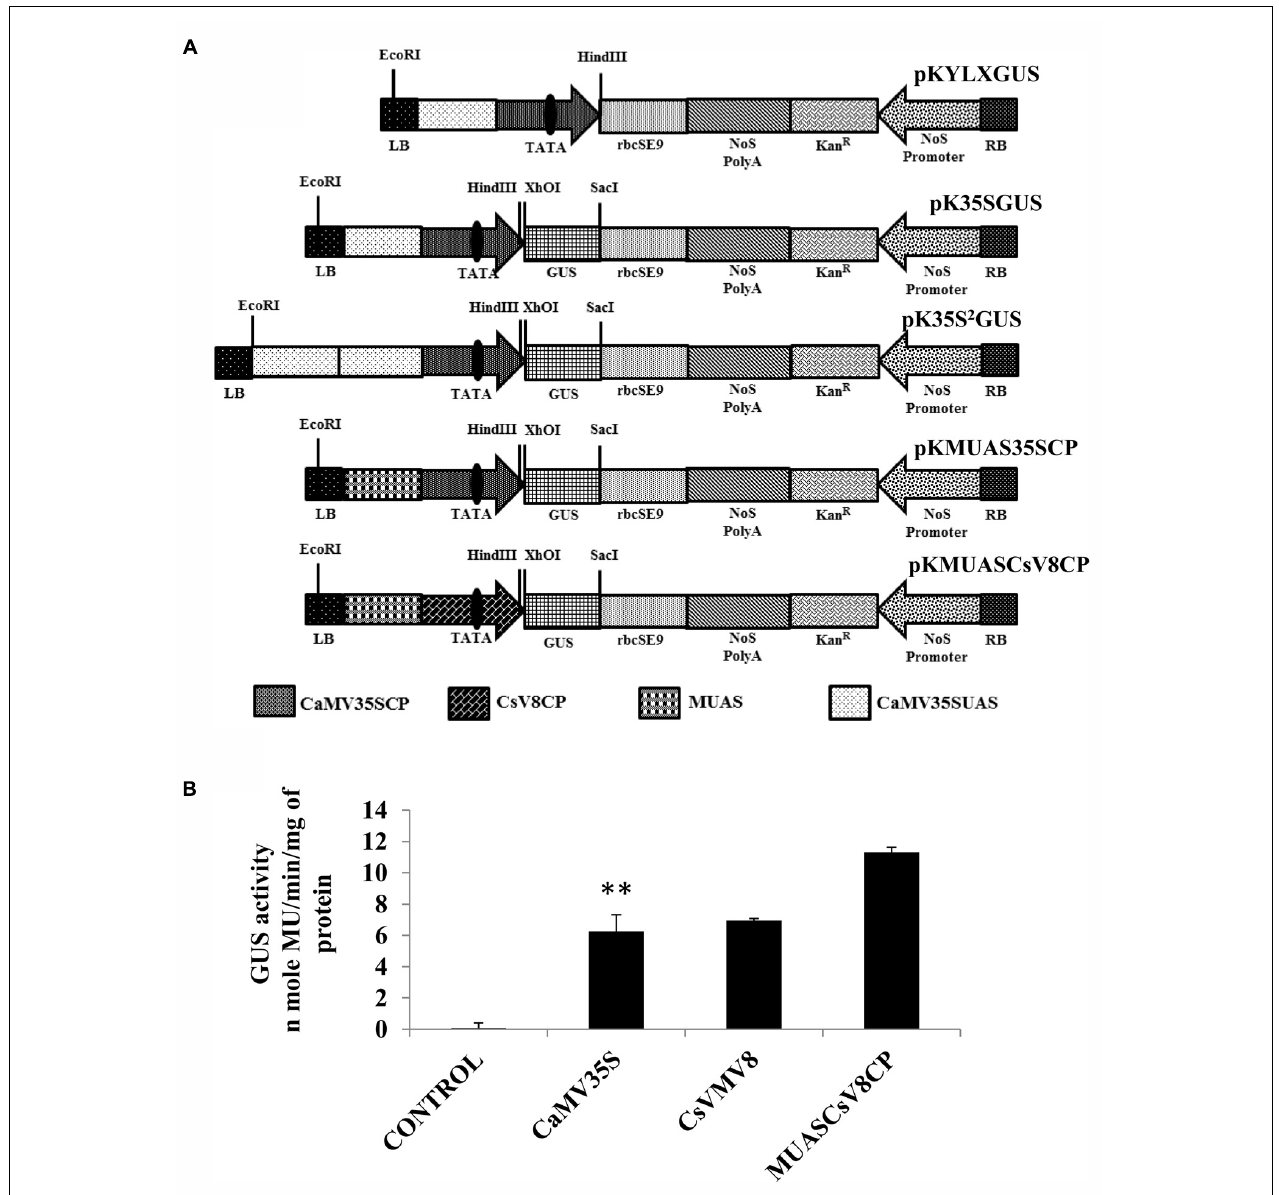
FIGURE 3 | (A) Graphical representation of plant expression vectors harboring promoter constructs namely pKYLX (containing 35S promoter), pKYLXGUS, pK35S 2 GUS, pK35SGUS, pKMUAS35SCP, and pKMUASCsV8CP coupled to GUS reporter gene. The relative position of UAS, CP with TATA element and different essential components of the expression cassette were illustrated. (B) Transient activity analyses of the above mentioned recombinant promoters in tobacco protoplasts. Asterisks indicate level of significance where “ ∗∗ ” is more significant than “ ∗